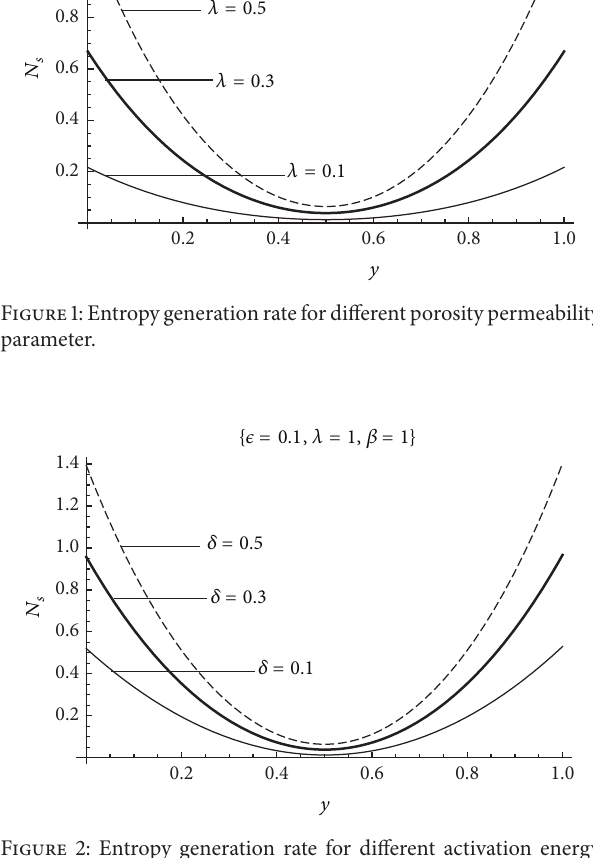
Figure 2: Entropy generation rate for different activation energy